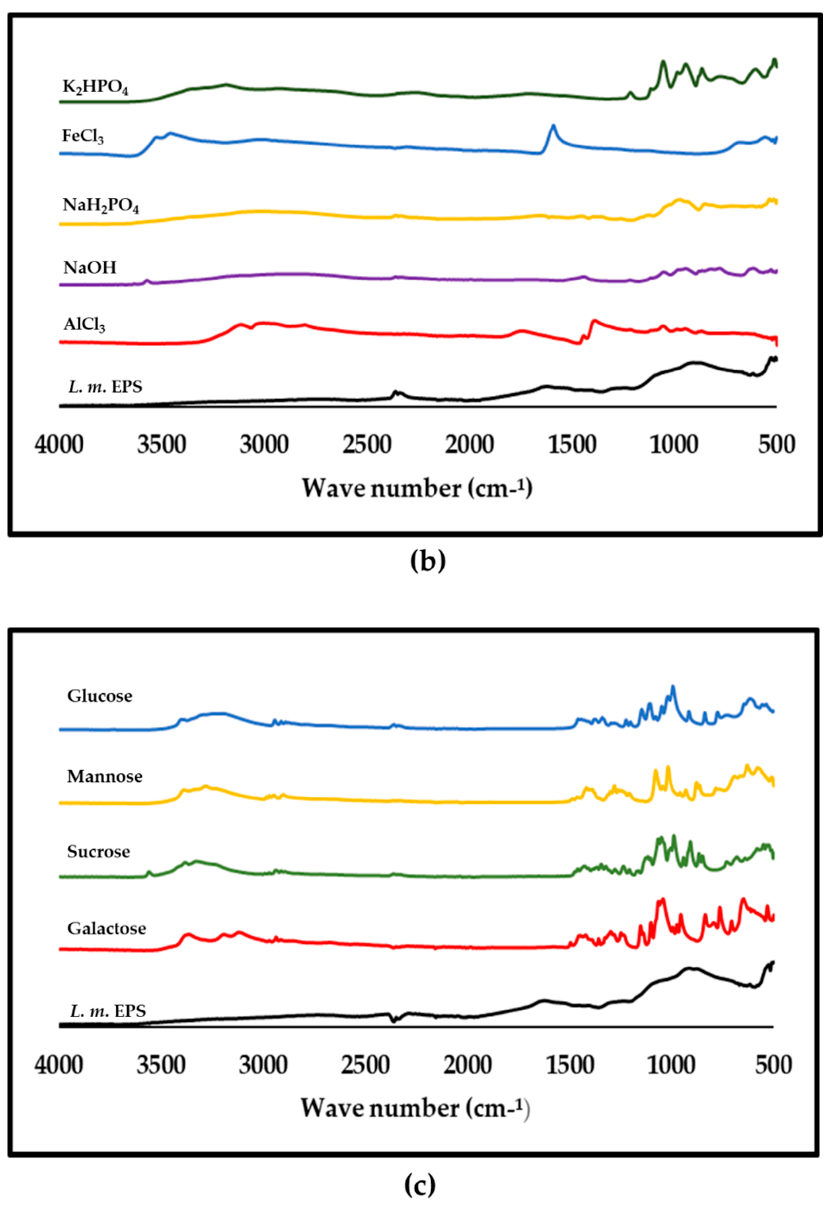
Figure 7. Attenuated total reflectance-Fourier transform infrared (ATR-FTIR) spectra of purified L. monocytogenes and other compounds. In panel ( a ), the EPS (the EPS of L. monocytogenes ) was compared with bovine serum albumin (BSA), DNA and glycerol. Panel ( b ) shows a comparison with the defined media components, which included aluminium chloride (AlCl 3 ), sodium hydroxide (NaOH) sodium dihydrogen phosphate (NaH 2 PO 4 ), ferric chloride (FeCL 3 ) and potassium phosphate (K 2 HPO 4 ). These ionic materials were used to test for the presence of impurities. Further comparisons were made with sugars ( c ); namely, galactose, sucrose, mannose and glucose.